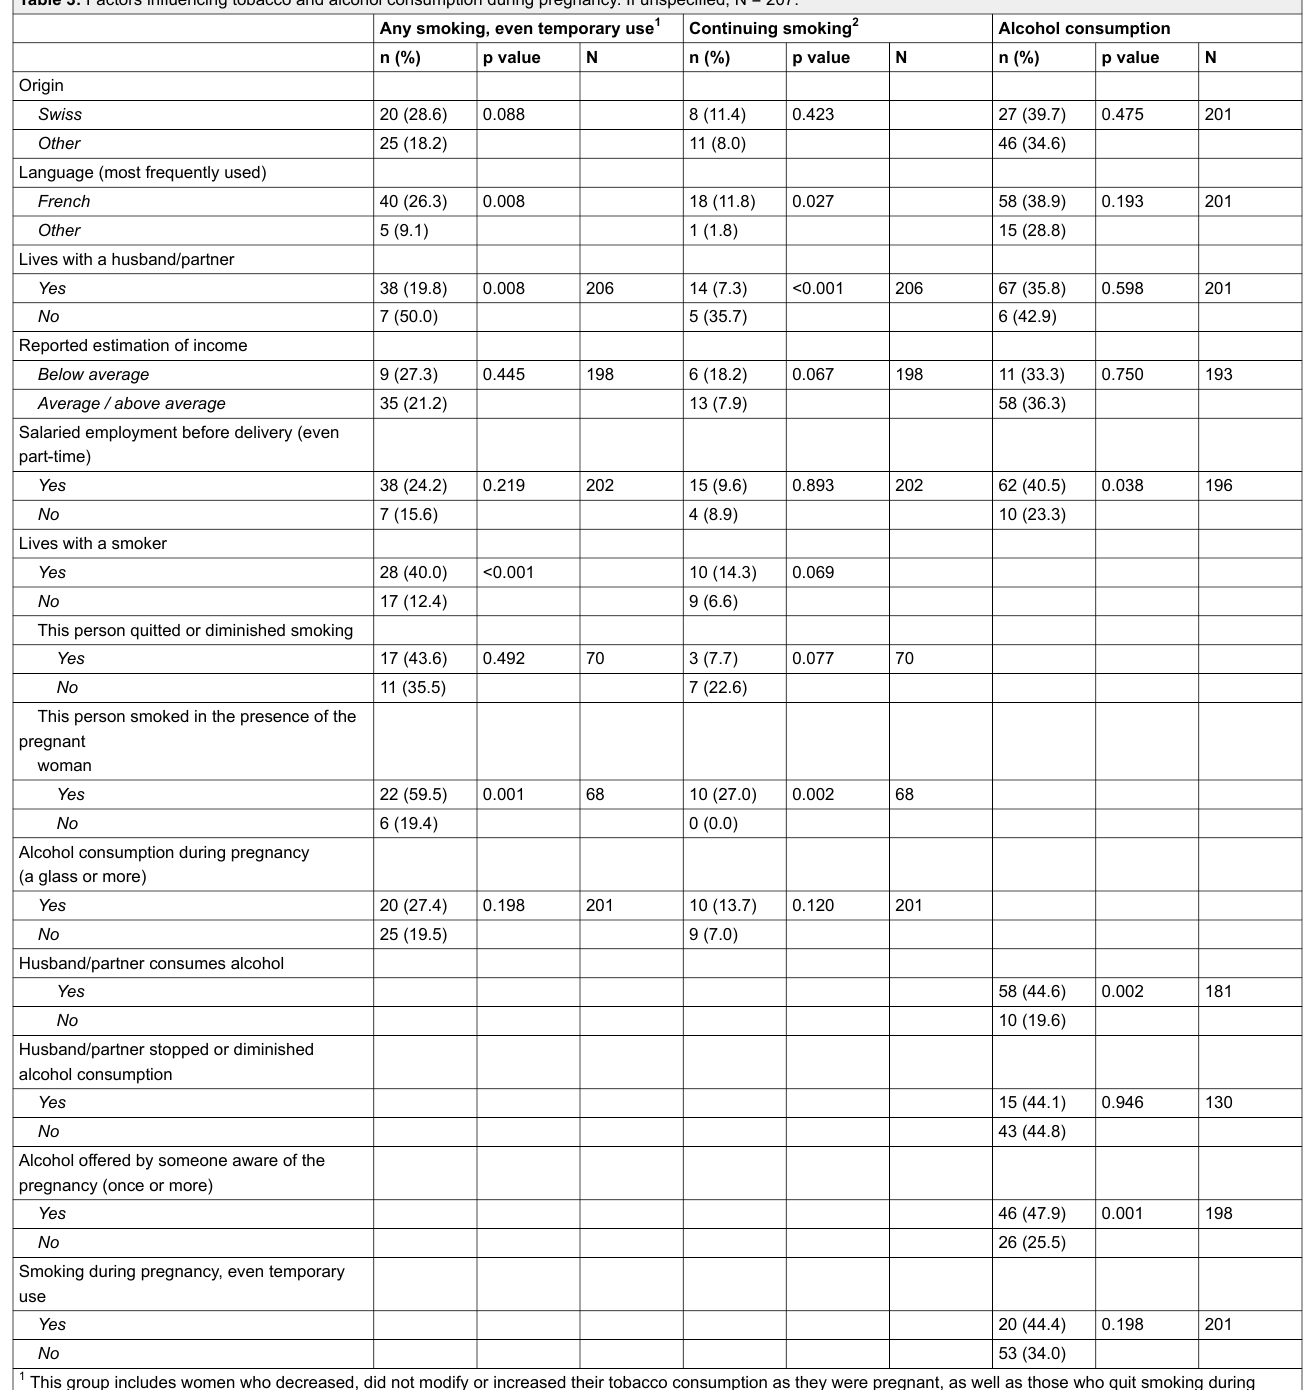
Table 3: Factors influencing tobacco and alcohol consumption during pregnancy. If unspecified, N =